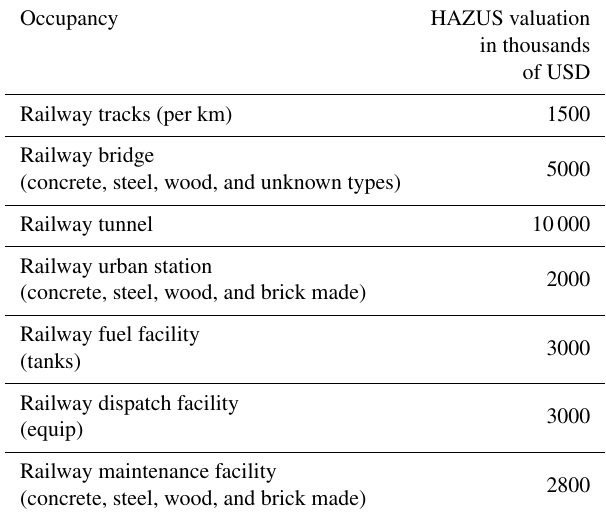
Table 1. Railway system classifications of the Federal Emergency Management Agency